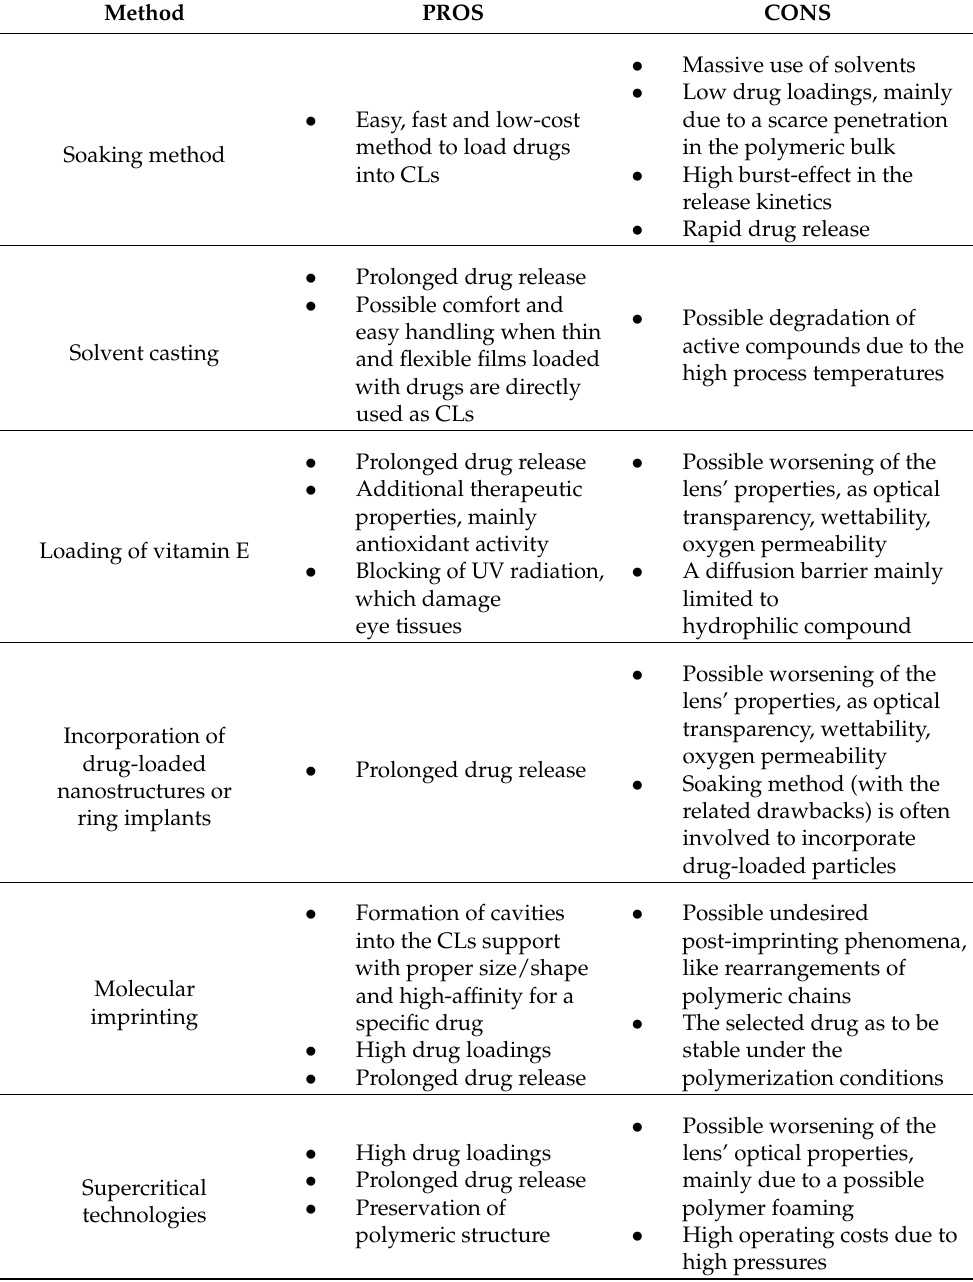
Table 4. Advantages and disadvantages of the main methodologies used to prepare drug-loaded contact lenses